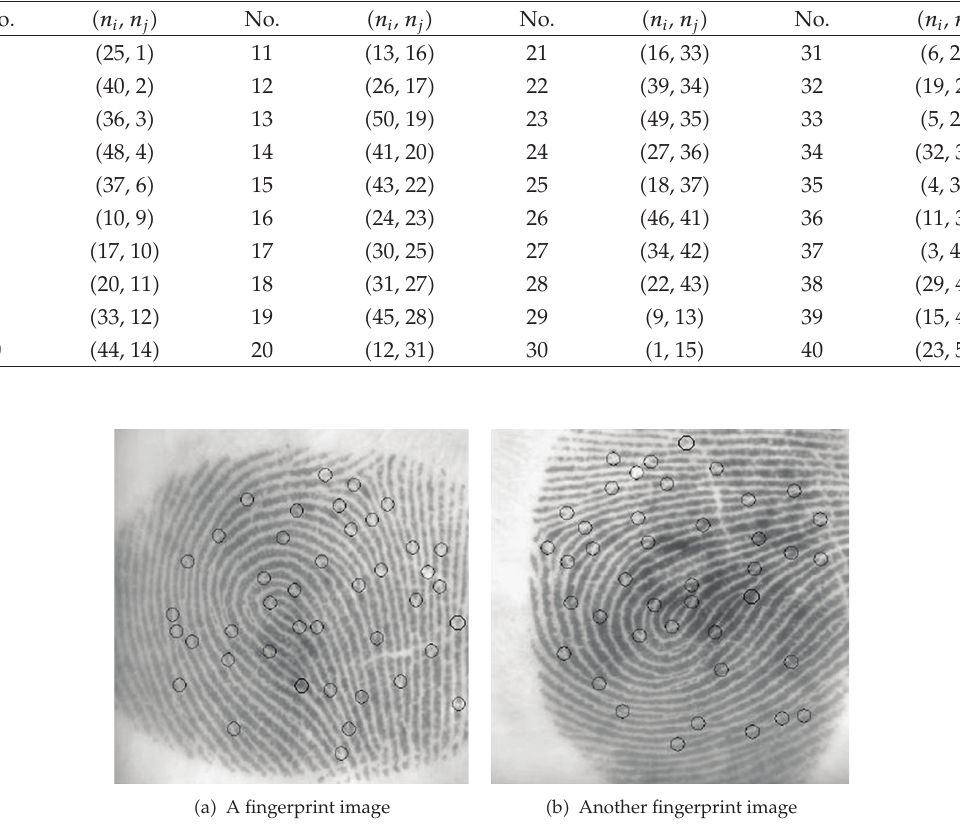
Figure 4: Two di ff erent fingerprint images from the same finger with circled features.